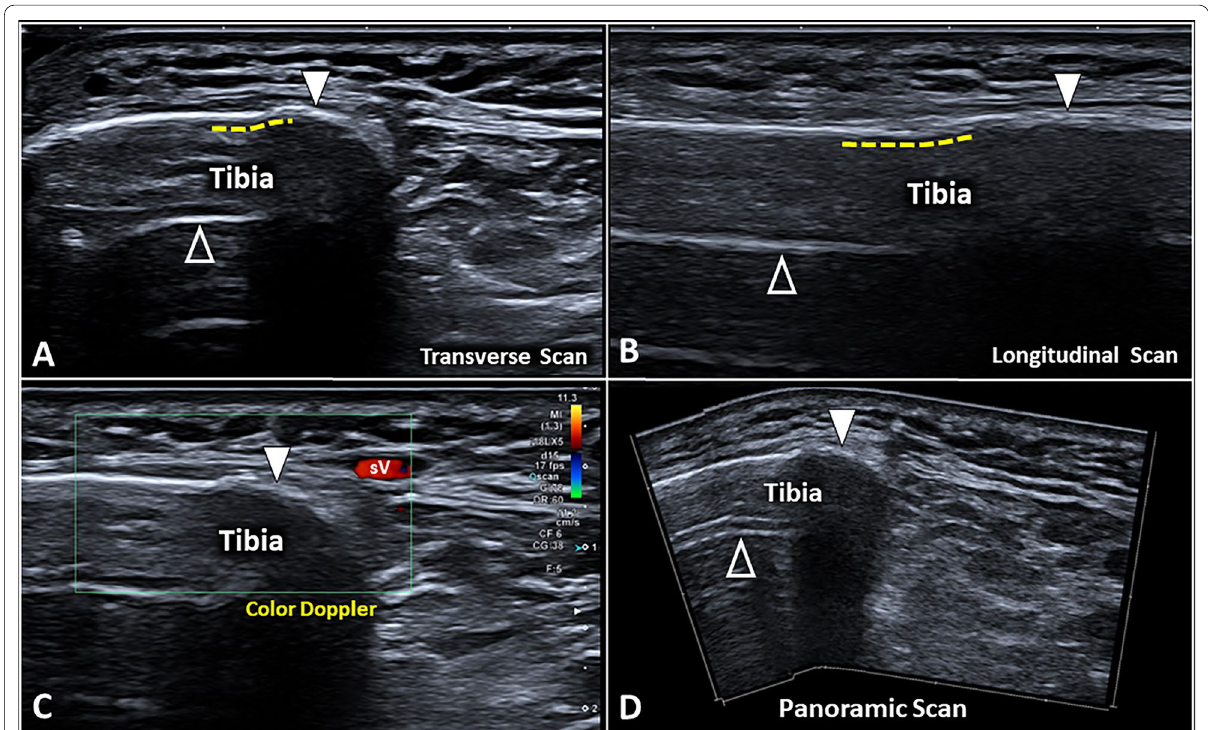
Fig. 6 Advanced stage of the bone callus. In the advanced stage, the bone callus ( white arrowhead ) presents as a hyperechoic line similar to the surrounding normal bone cortex, but the underlying reverberation artifact ( void arrowhead ) can be absent ( A ). Of note, the aforementioned artifact stops abruptly exactly at the transitional zone ( yellow dotted line ) from the normal bone cortex to the bump of the callus ( white arrowhead ) ( A , B ). No vascular signals ( C ) can be visualized within/surrounding the bone callus ( white arrowhead ) defining the completed healing status of the bone fracture ( D ). sV superficial